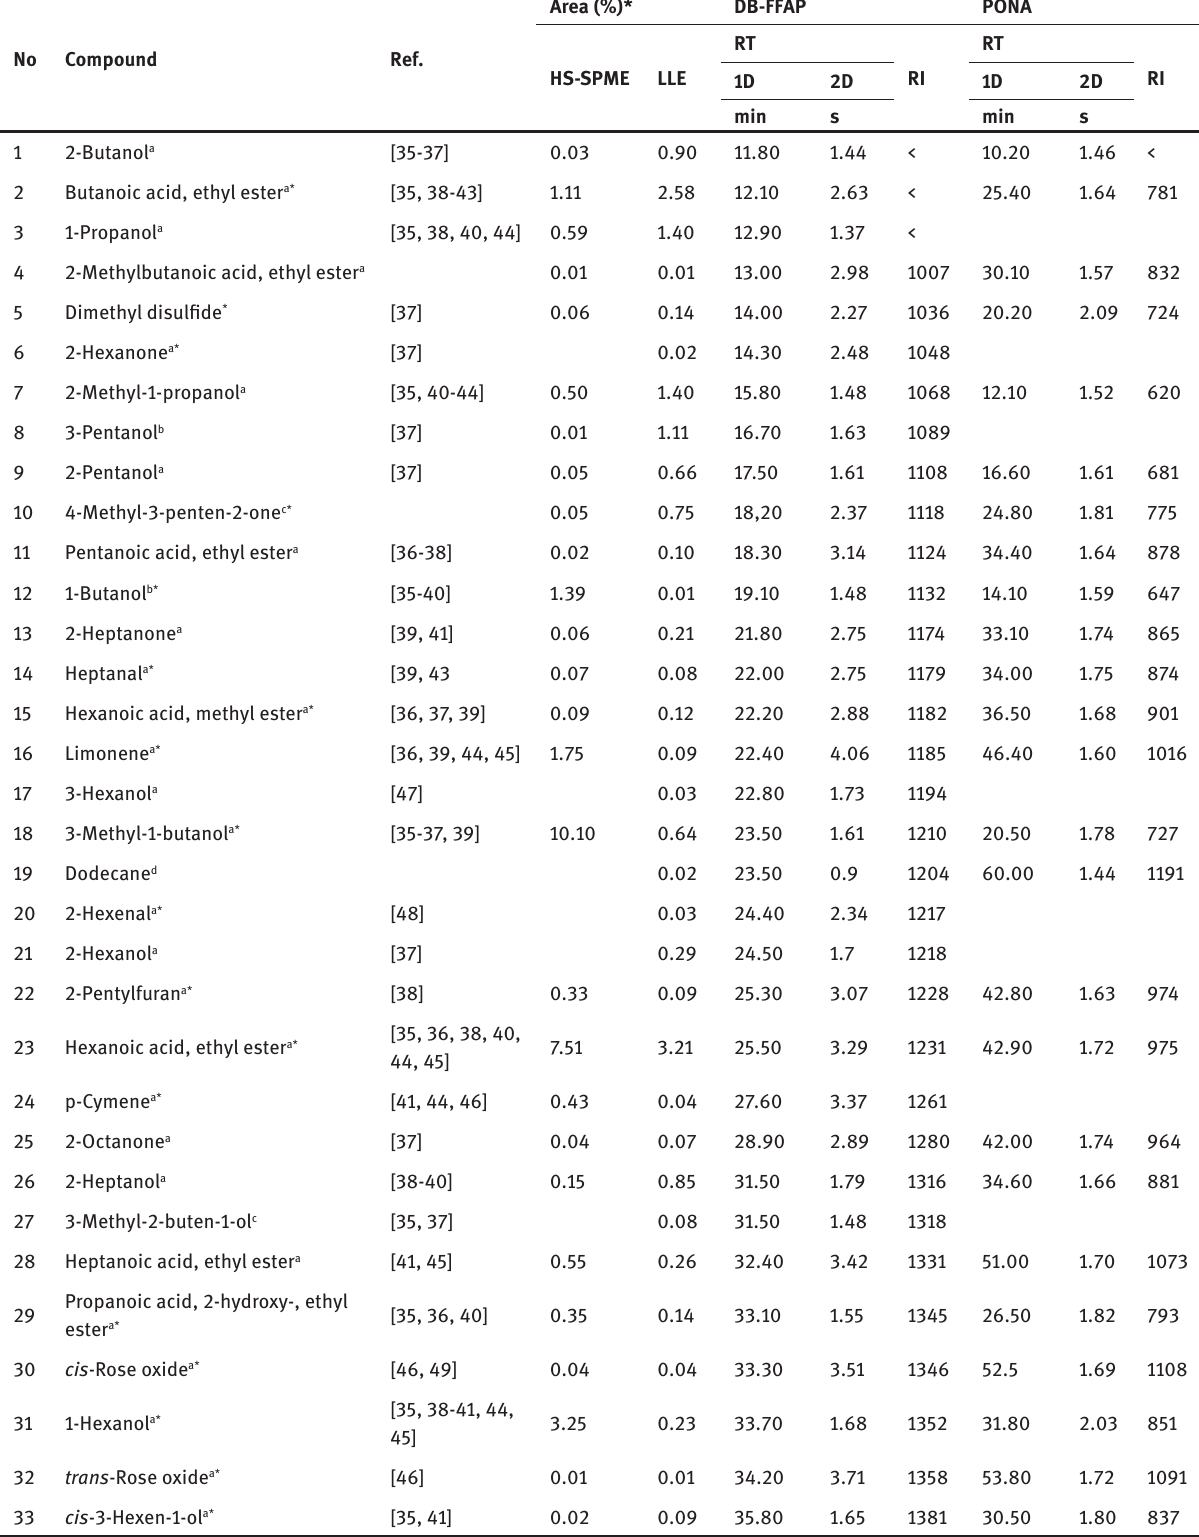
Table 1: Compounds identified in spirit distilled from Sorbus domestica by GCxGC-TOFMS.